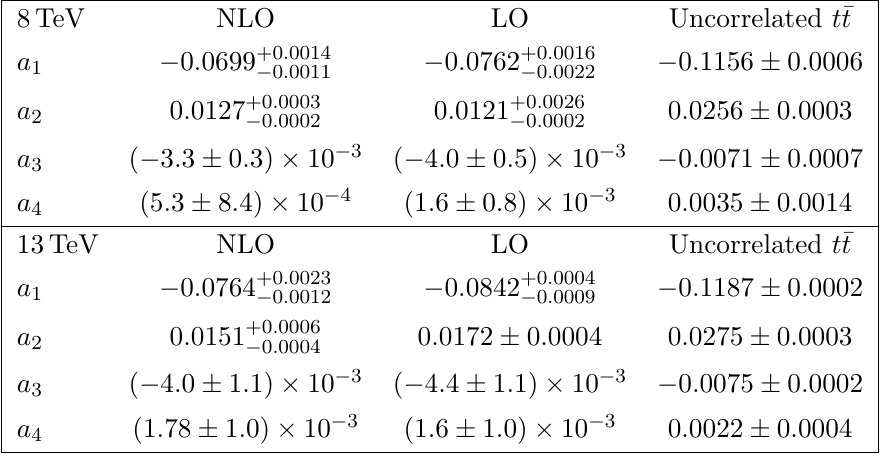
Table 3 . Lowest order coe(cid:14)cients in the expansion (2.1) of the normalised d(cid:27)=d(cid:30) distribution, for CM energies of 8 TeV (up) and 13 TeV